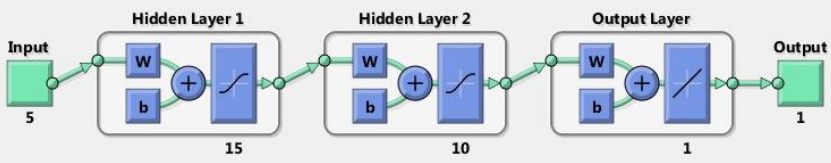
Figure 4. The architecture of the selected ANN.